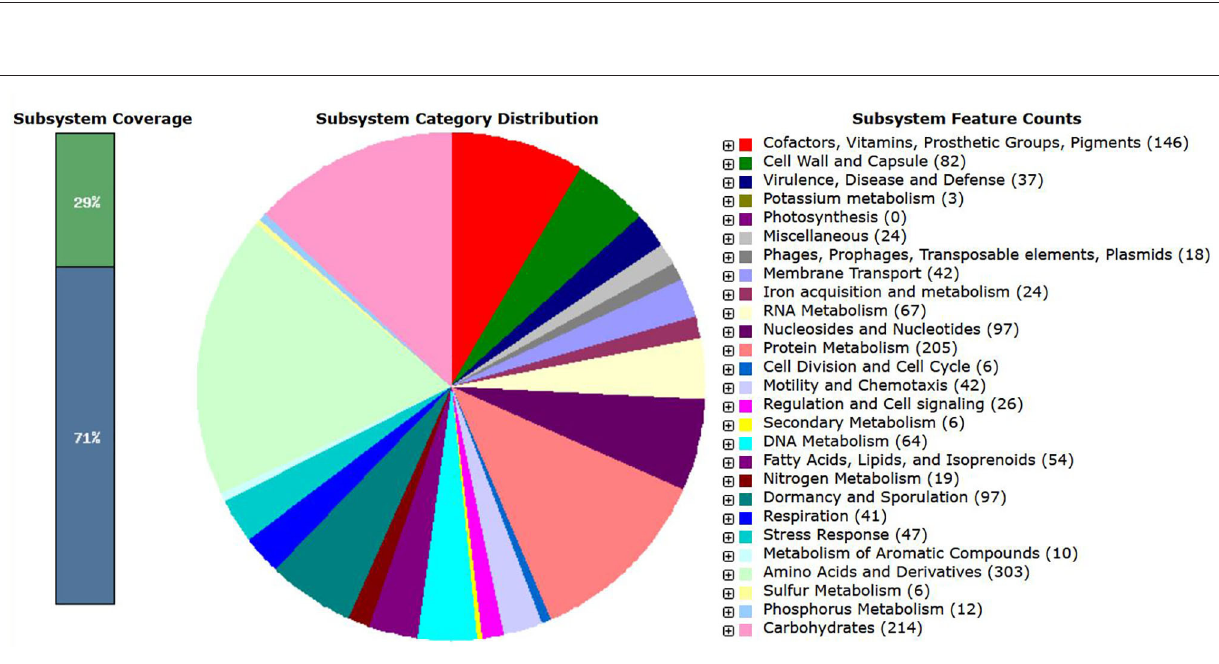
Frontiers in Genetics |